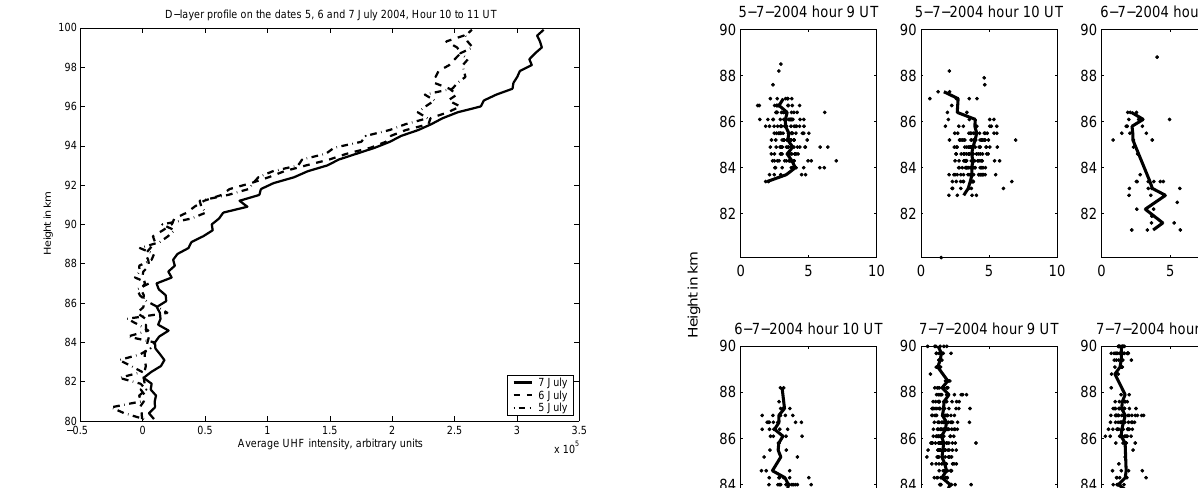
Fig. 11. A plot of the lower part of the D-layer as observed with the EISCAT UHF (933MHz) radar on the dates 5, 6 and 7 July 2004.